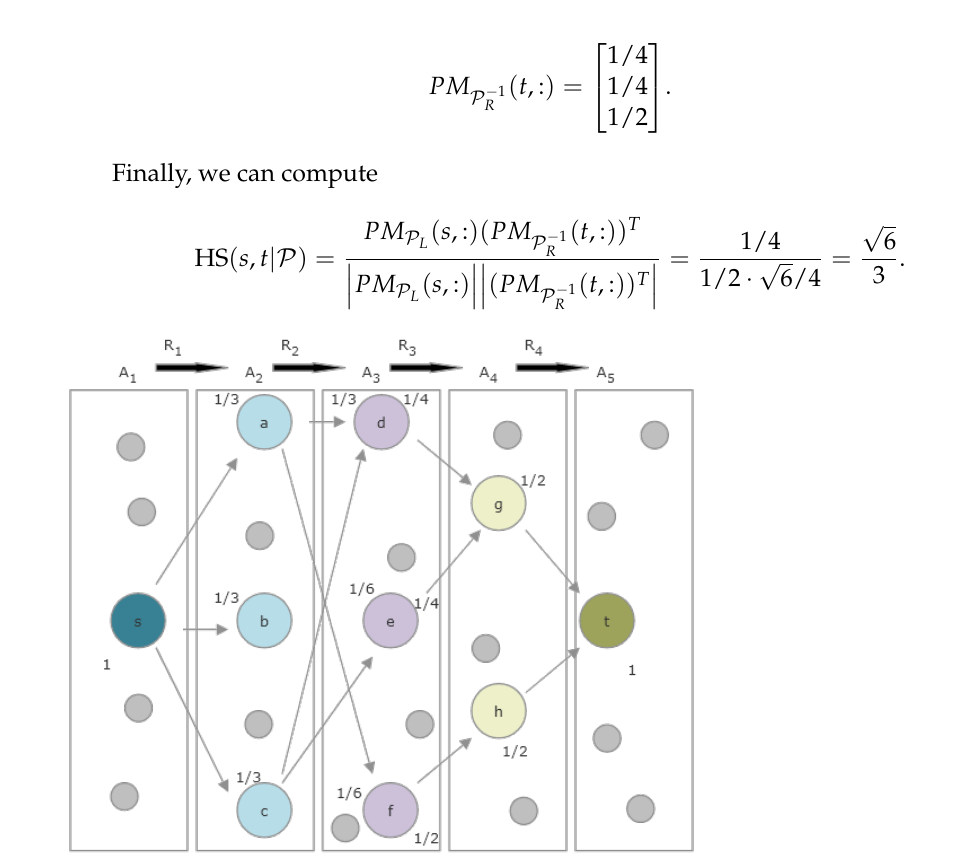
Figure 1. Example graph, metapath, and HeteSim